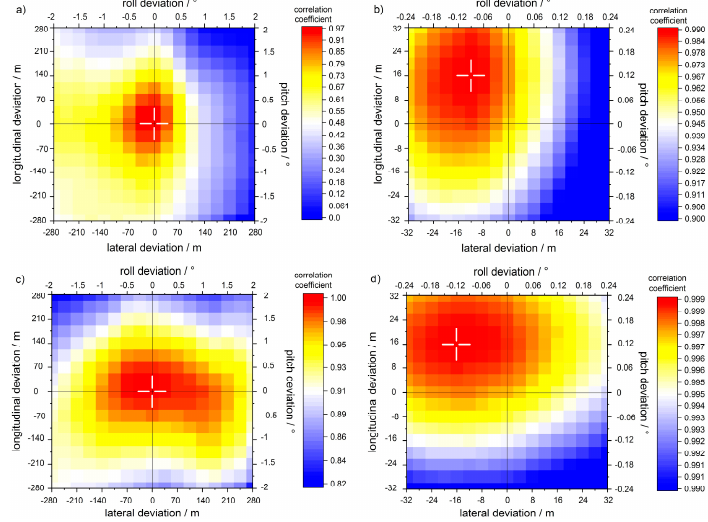
Figure 4. Resulting correlation arrays for check intervals of 4 km for two different test sections. Section 1: panel ( a ) and ( b ), section 2: panel ( c ) and ( d ). On the left: coarse resolutions with a deviation range up to 280 m laterally and longitudinally; On the right: fine resolutions with a deviation range up to 32 m. The white cross marks the roll and pitch angles for maximum correlation between lidar SSEs and DEM data. (Angle indications are valid for a 9000 m flight altitude. Note that the scales of the color bars differ in each case).